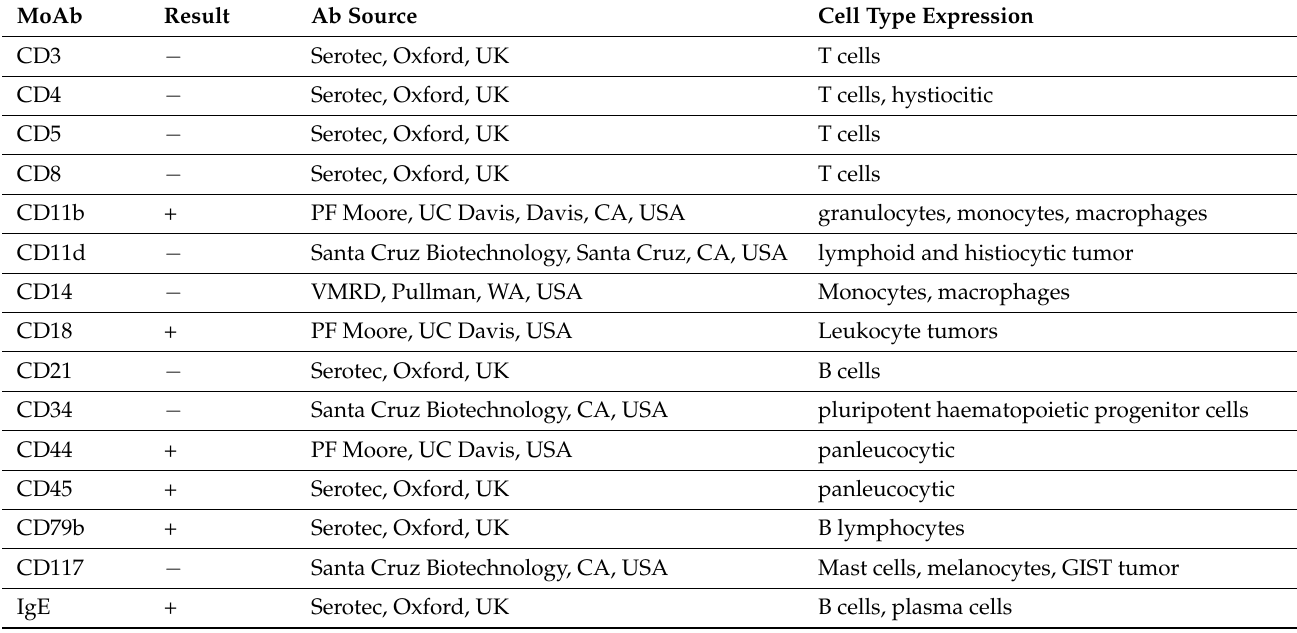
Table 1. Flow cytometry antibodies used to identify cell surface antigens (CD = cluster of differentiation), with their cell type expressions, results and sources, in a case of cutaneous non epitheliotropic B-cell lymphoma (CNEBL) vs. multiple cutaneous plasmacytosis (CP) in a dog. MoAb = monoclonal antibody, Ab = antibody.